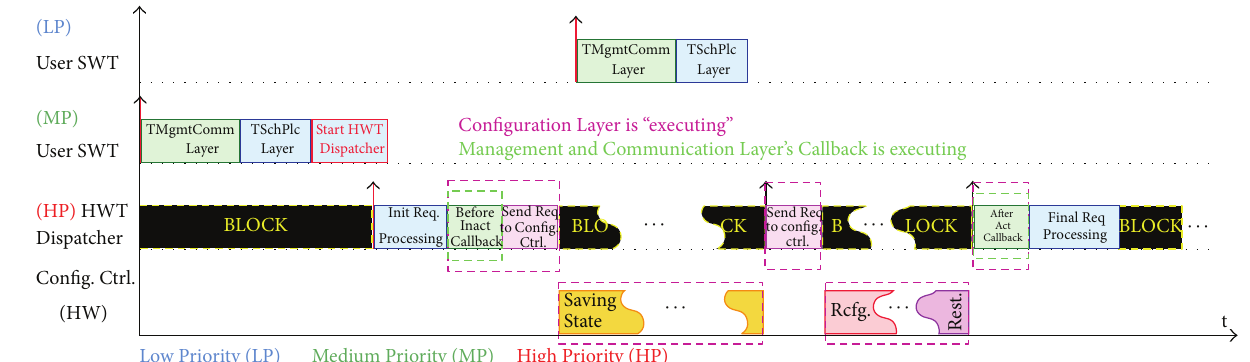
Figure 9: Delayed execution of configuration requests.